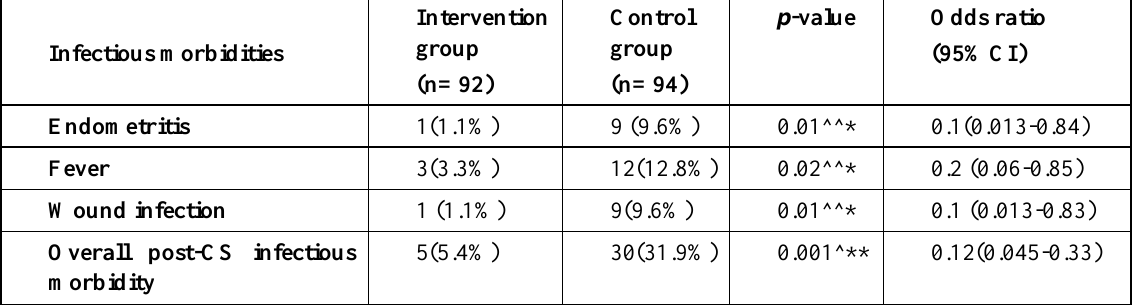
Intervention Control p -value Odds ratio group group (95%CI) (n= 92) (n= 94)